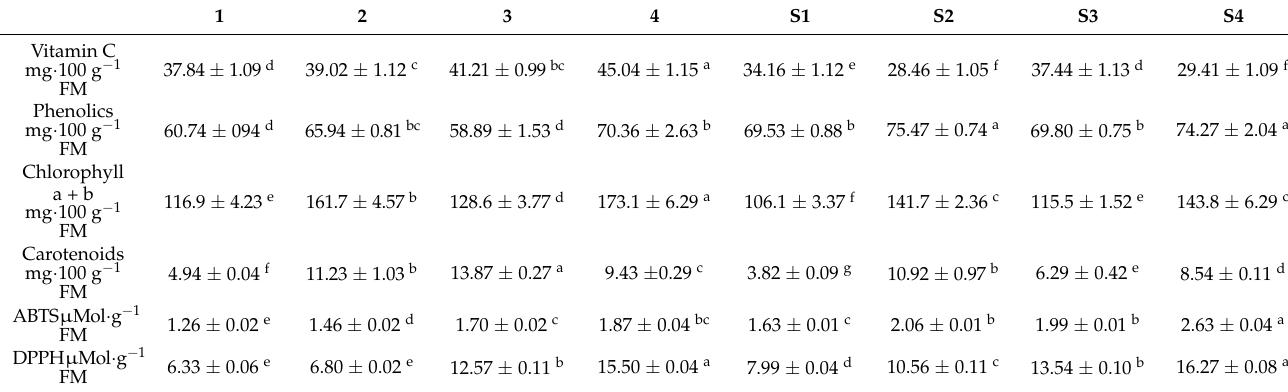
Table 1. Antioxidant activity and vitamin C, polyphenol, chlorophyll a and b, and carotenoid content for fresh and stored white